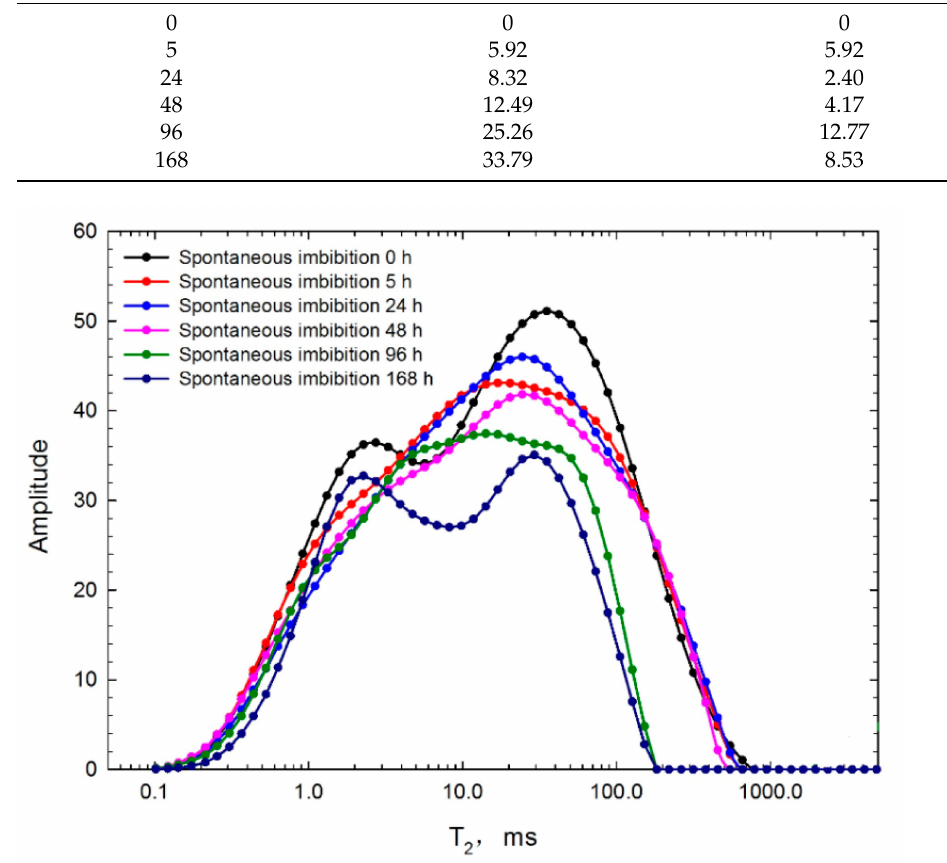
Figure 12. The T2 spectrum distribution curve of spontaneous imbibition in core